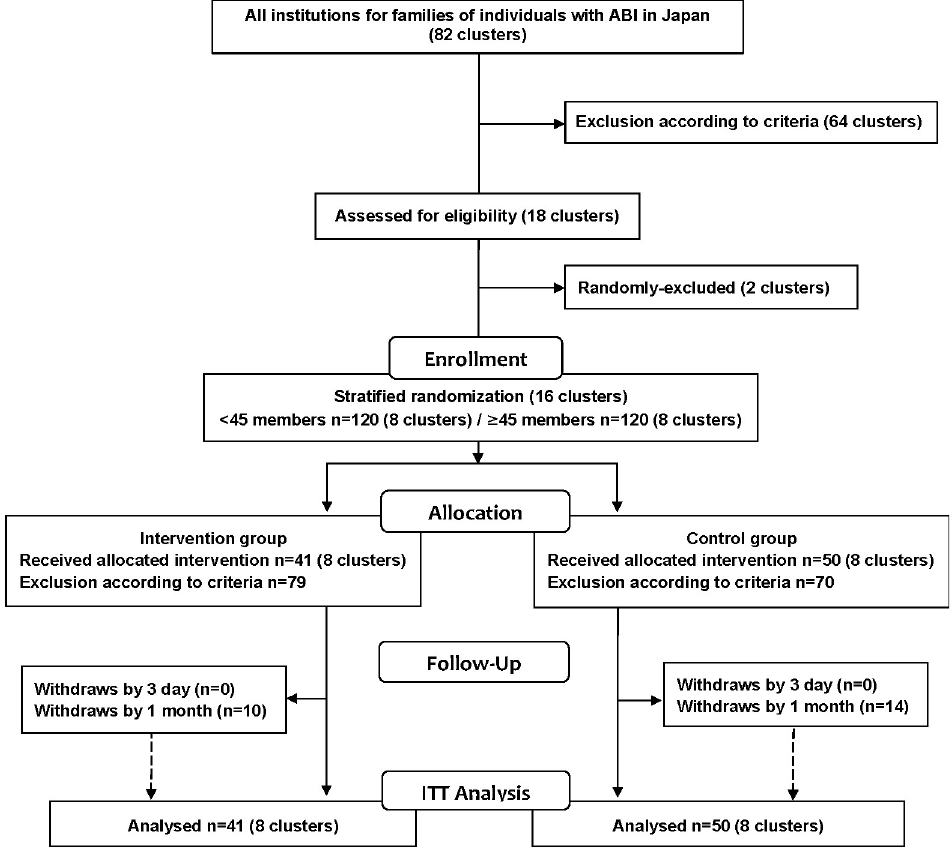
Fig 1. Flow of the